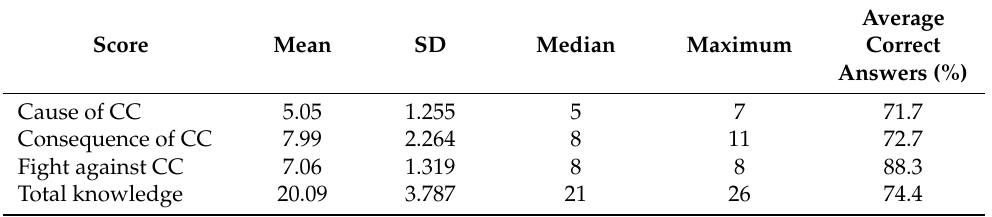
Table 3. Score of knowledge about CC of the study population.